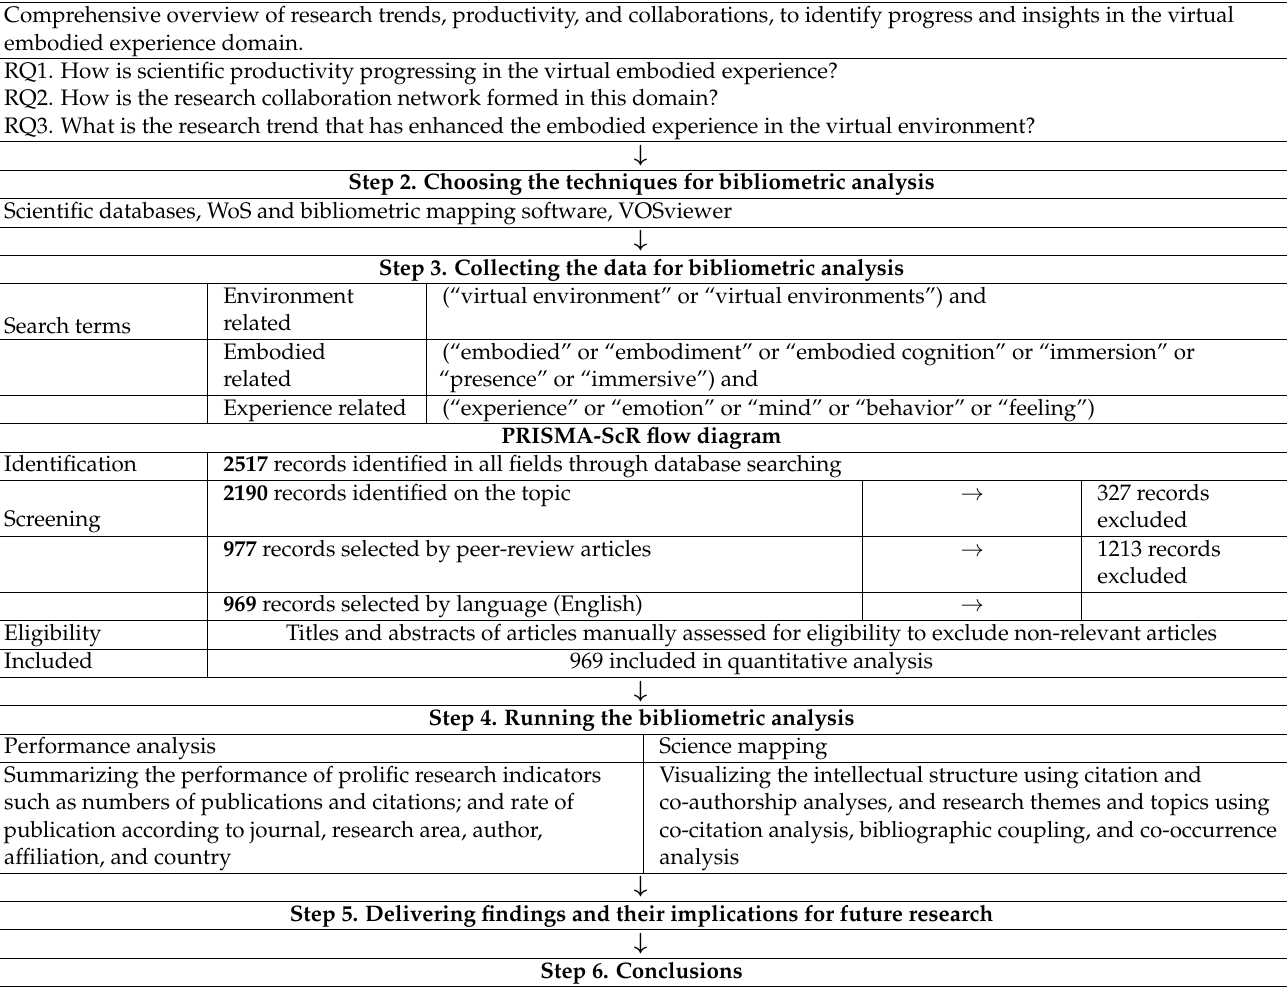
Table 1. The bibliometric analysis